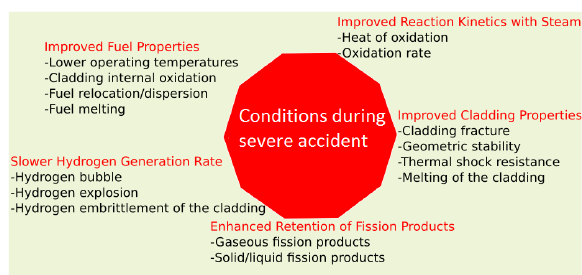
Figure 2. Major issues that need to be addressed in establishing accident tolerant fuel